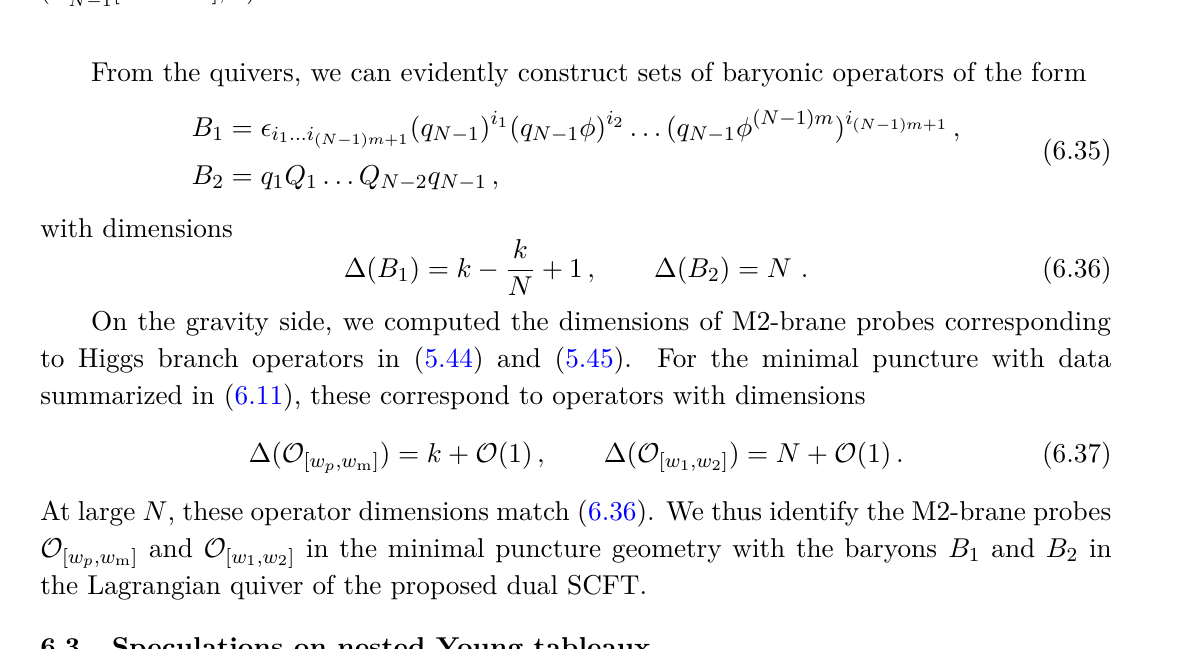
Figure 9. The upper figure is the UV quiver and the lower figure the IR quiver for the flow to the ( A ( N ) [ k = mN ] , S ) N − 1